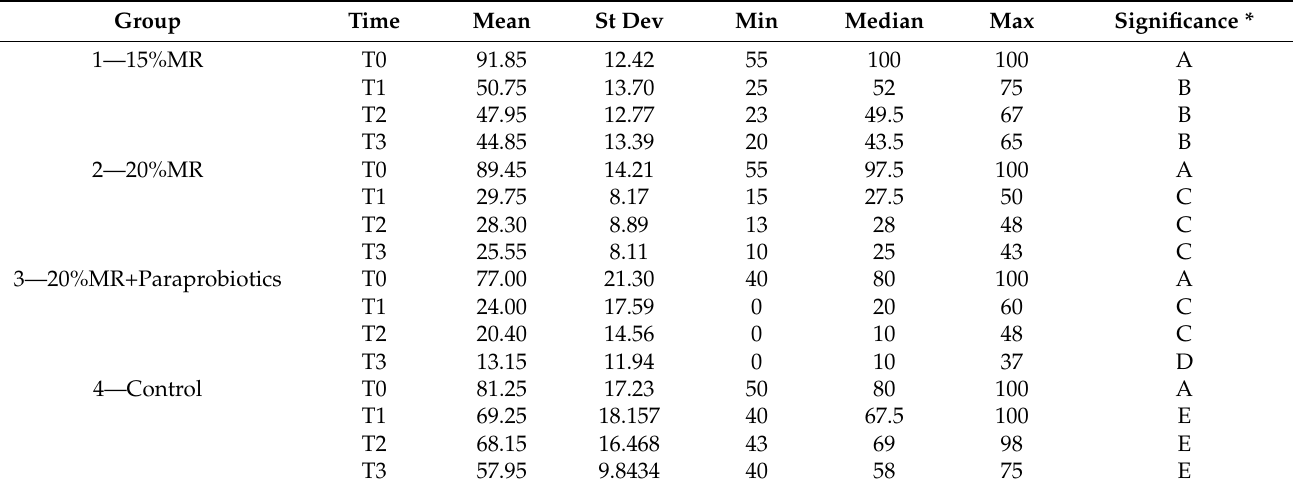
Table 3. Descriptive statistics of bleeding on probing (BoP)